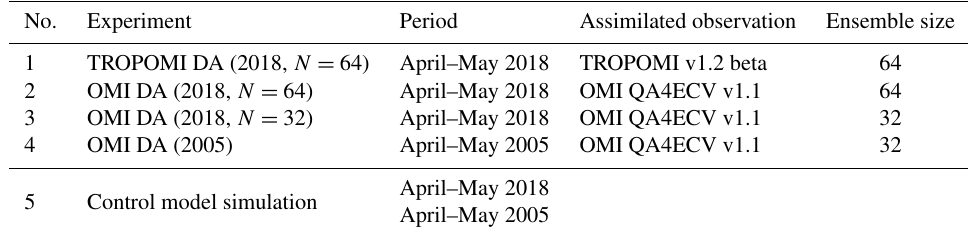
Table 1. List of data assimilation and control model simulation runs performed in this study. No. Experiment